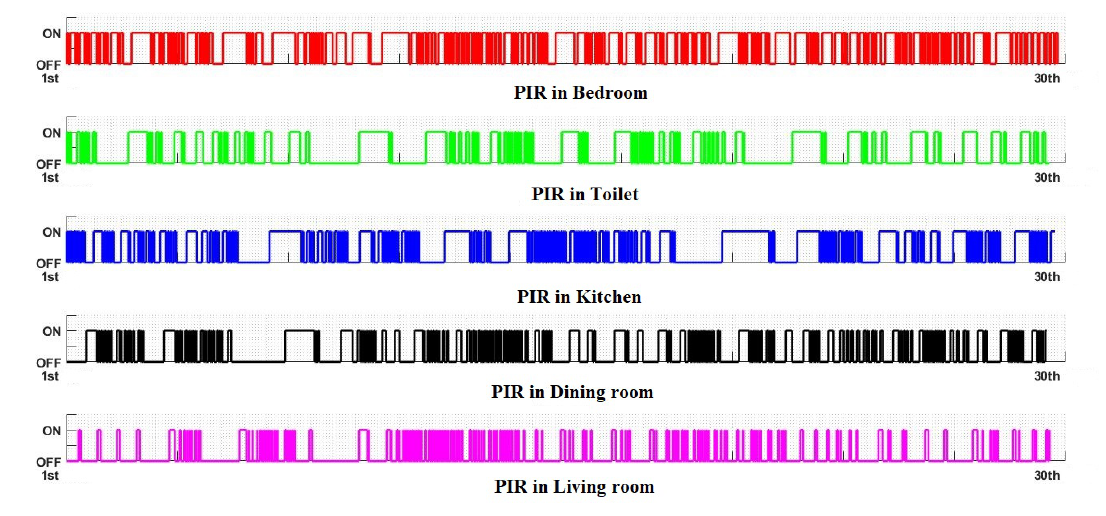
Figure 4. A sample of raw data gathered from PIR sensors over a one-month